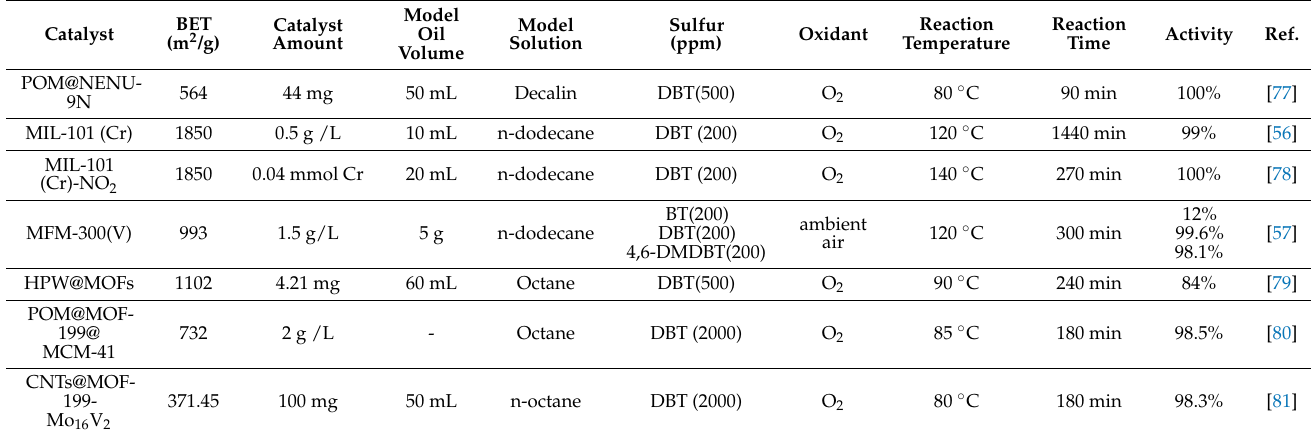
Table 4. Comparison on the AODS catalytic performance of MOFs-based